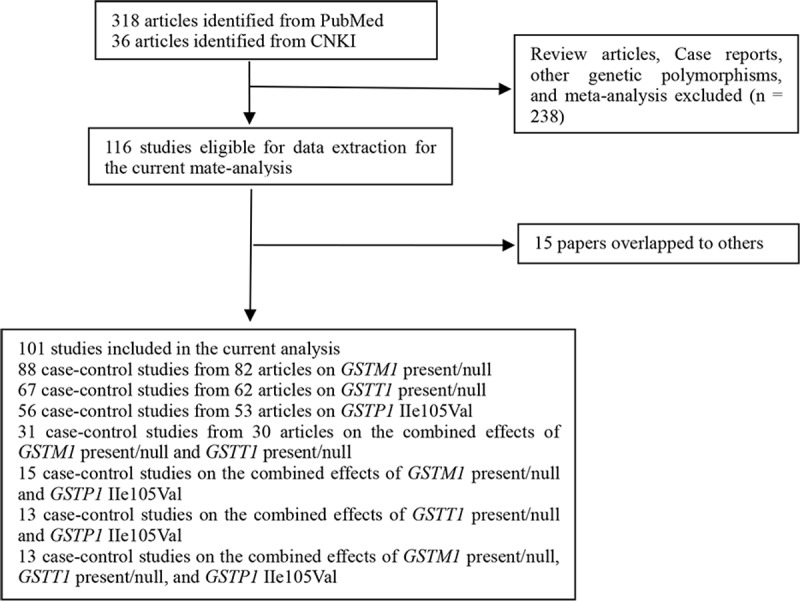
Flow diagram for identifying and including studies in the current meta-analysis.